Question: Briefly state, in one sentence, what is plotted here.
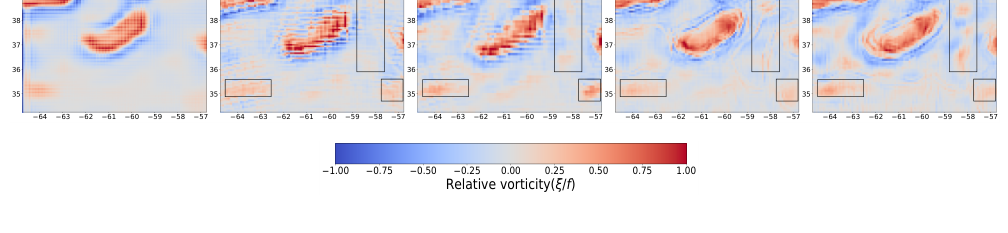
Answer: SSH maps and Relative Vorticity maps (normalized by the Coriolis frequency) of